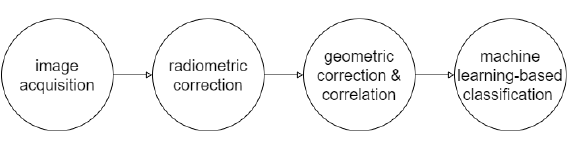
Figure 1. The workflow of the mapping methodology.